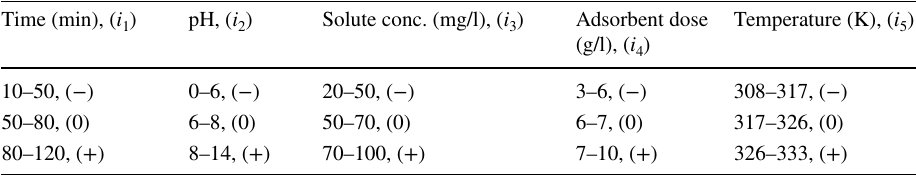
Table 1 Process variables with their various chosen levels for the batch adsorption of MG using